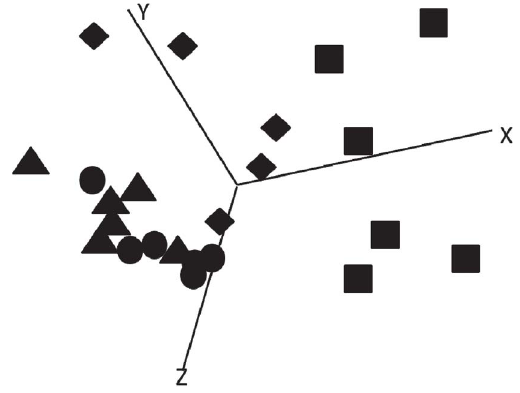
Figure 1. Example of proteome profile differences between Figure 2. Principal component analysis. Control and diabetic pigs control and diabetic pigs fed two diets. Control and diabetic pigs were either fed a healthy Mediterranean diet or a cafeteria diet differing were either fed a healthy Mediterranean diet or a cafeteria diet differing mainly in fatty acid composition. Plasma protein profiles were mainly in fatty acid composition. Plasma protein profiles were determined with a SELDI-TOF equipment and analyzed in relation to determined with a SELDI-TOF equipment and analyzed in relation to physiological parameters. Example of the principal component analysis physiological parameters. Expression levels of peak M/Z 28537, CM10 of peaks showing differential expression between the groups of pH 7, fraction 3. Each dot represent the expression level found in a pig. N N animals: peak M/Z 6623, CM10, pH 7, fraction 3; m : Control The horizontal bar represents the mean. m : Control Mediterranean diet, ¤ : Control Cafeteria diet, : Diabetes Mediterra- Mediterranean diet, ¤ : Control Cafeteria diet, : Diabetes Mediterranean diet, & : Diabetes nean diet, & : Diabetes cafeteria diet. cafeteria diet.